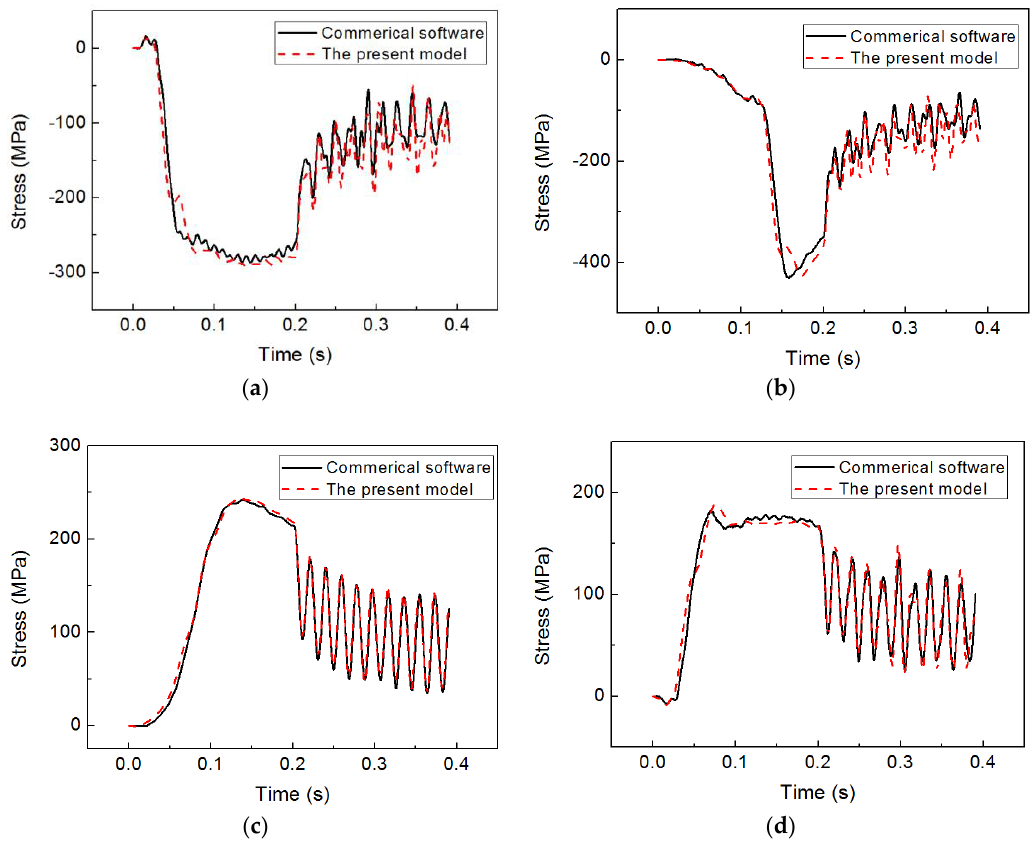
Figure 8. Comparison between results of the present model and the commercial software. ( a ) S1; ( b ) S3; ( c ) S5; ( d ) S7. S1–S7 represent the locations on the stiffened plate for the analysis of structural